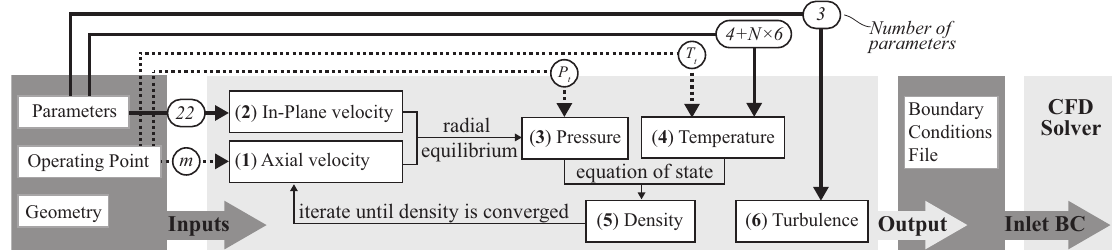
Figure 1. Structure of the interface parameterisation algorithm. CFD: computational fluid